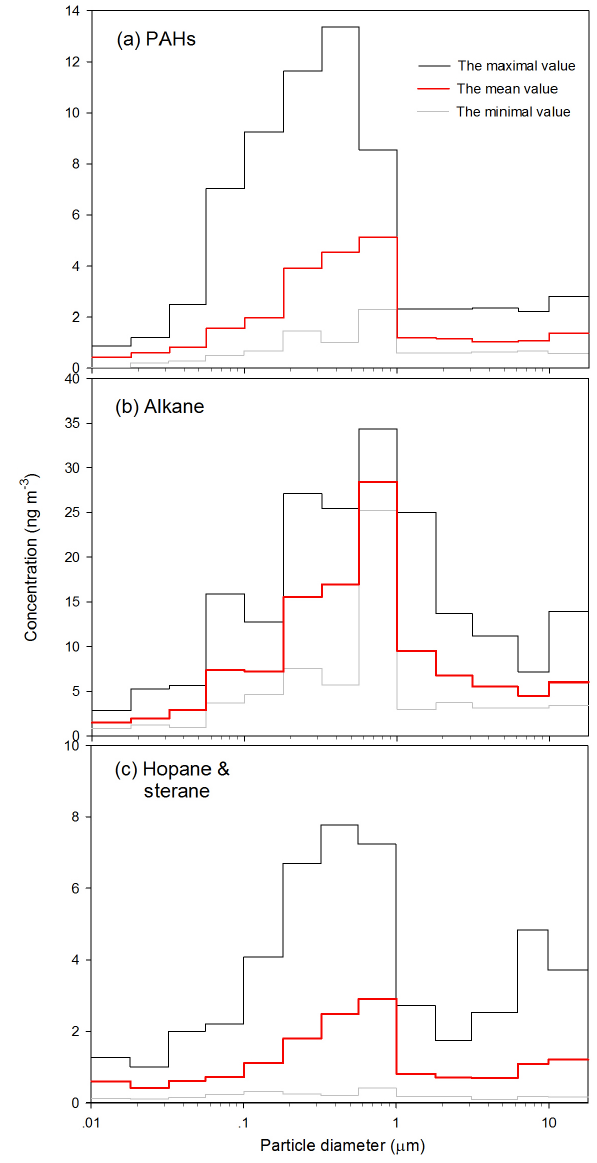
Figure 4. Mean-normalized size-specific distribution of NPOCs in the collected PM 2 . 5